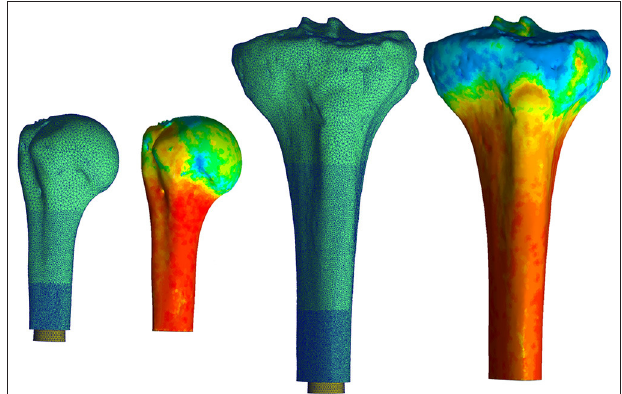
FIGURE 1 | Mesh for both the humerus (left) and tibia (right) began proximally with a coarse mesh controlled with a maximum edge length of 1.2mm. This progressed into a finer mesh distally with a maximum edge length of 0.2mm around the endoprosthesis. Heat map represents Young’s Modulus values assigned to each element based on voxel intensity. Pictured humerus and tibia; Young’s Modulus ranged from 0.007 (blue) to 14.8 GPa for the humerus and was 16.8 GPa for the tibia (red). The results of this material assignment were similar for all the other bones modeled. * Relative sizes of the bones are approximately to